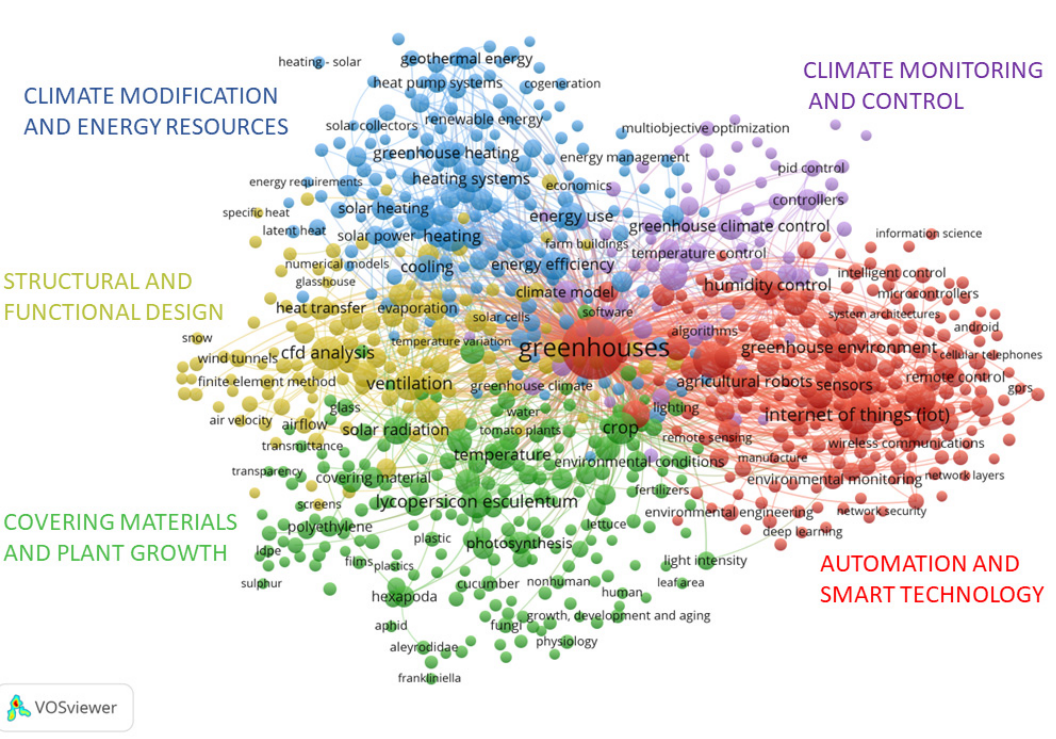
Figure 7. Keywords network based on the greenhouse engineering publications from 1981 to 2021.